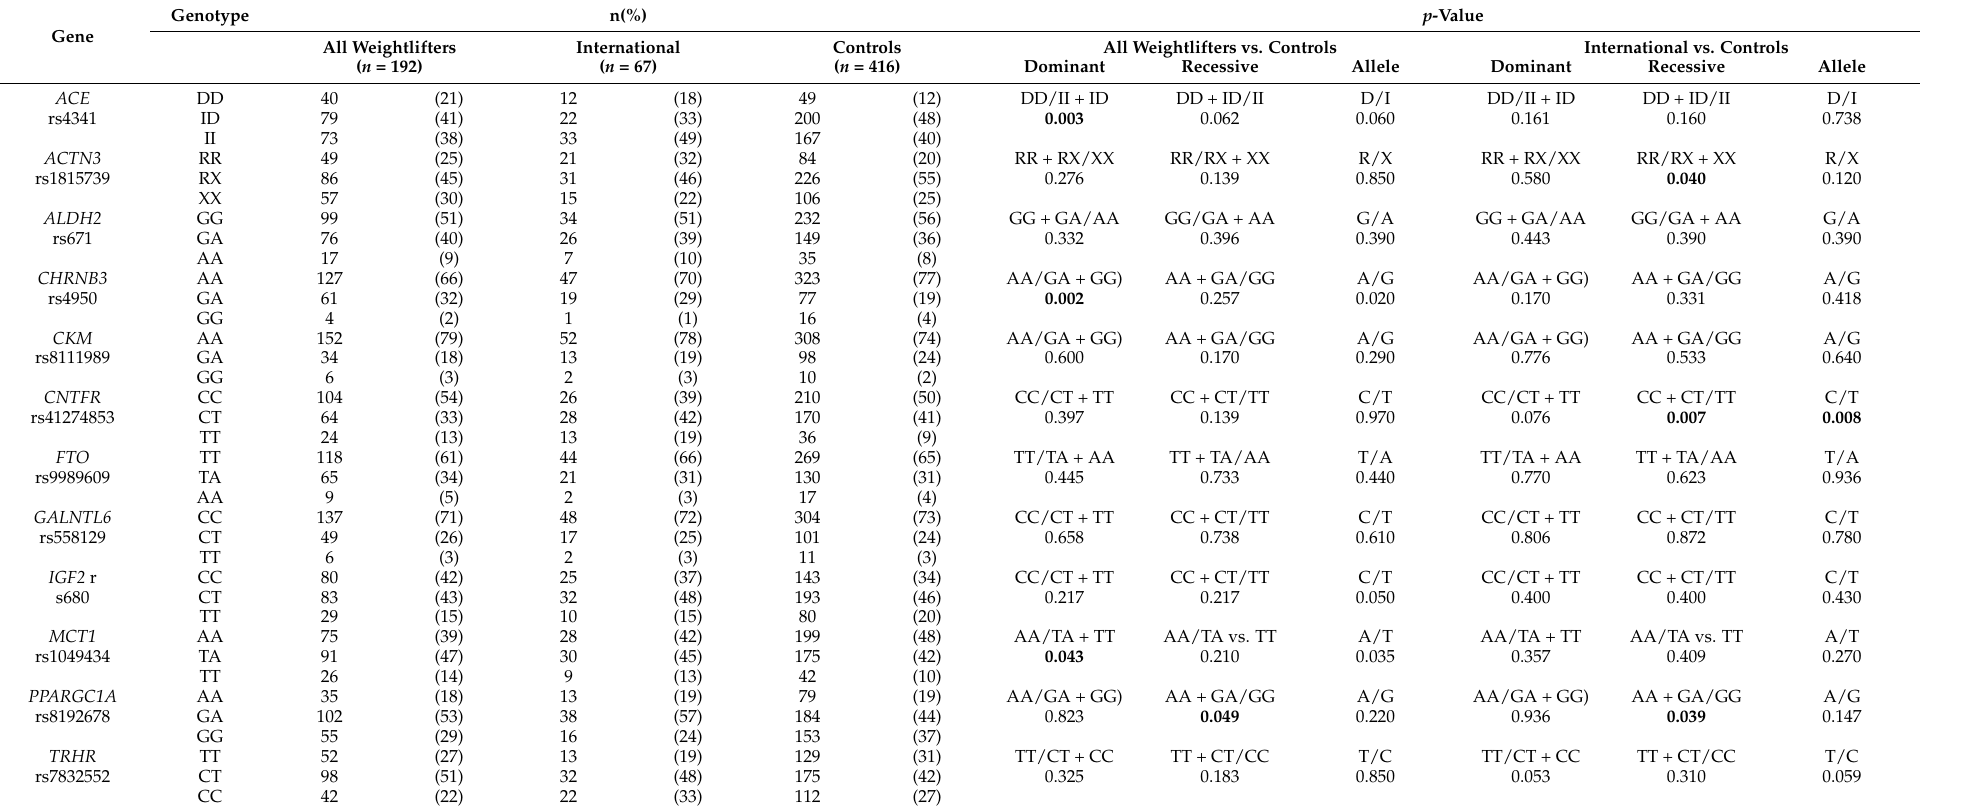
Table 2. Frequency of 12 polymorphisms in weightlifters and